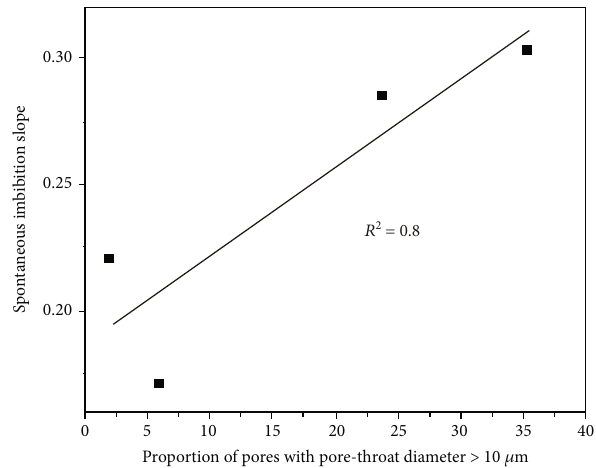
Figure 12: Relationship between spontaneous imbibition slope with (a) proportion of pores with pore- throatdiameter > 10 μ m (excluding the two-slope spontaneous